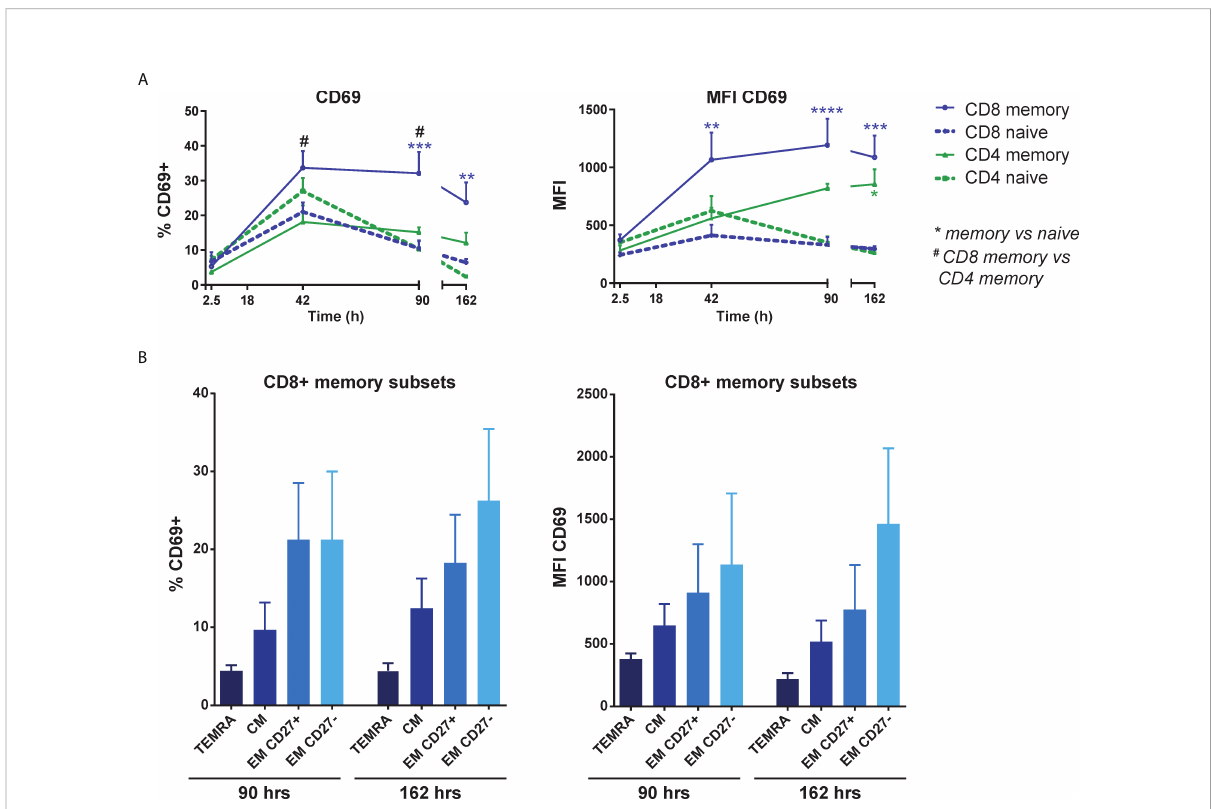
FIGURE 3 EC-induced CD69 expression is most pronounced in effector memory CD8+ T cells. HMEC were stimulated with 10 ng/mL TNF a and IFN g for 3 days before addition of FACS-sorted naive CD3+ or memory CD3+ T cells to the co-culture. CD69 expression was assessed at various time points of the co-culture by fl ow cytometry. (A) Percentage of CD69+ cells (left panel) and median fl uorescent intensity (MFI) of CD69 (right panel) on naive and memory CD4+ and CD8+ T cells. N = 4, mean+SEM. 2-Way-ANOVA with Sidak post-hoc test. */#P < 0.05, **P < 0.01, ***P < 0.001,****P < 0.0001. (B) Percentage of CD69+ cells (left panel) and median fl uorescent intensity (MFI) of CD69 expression (right panel) on sorted CD8+ memory T cell subsets after co-culture with activated HMEC. TEMRA, terminally differentiated CD45RA+ effector memory T cells (CD45RA+CCR7-); CM, central memory T cells (CD45RA-CCR7+); EM, effector memory T cells (CD45RA-CCR7-). N = 6, mean+SEM. 2- Way-ANOVA with Sidak post-hoc